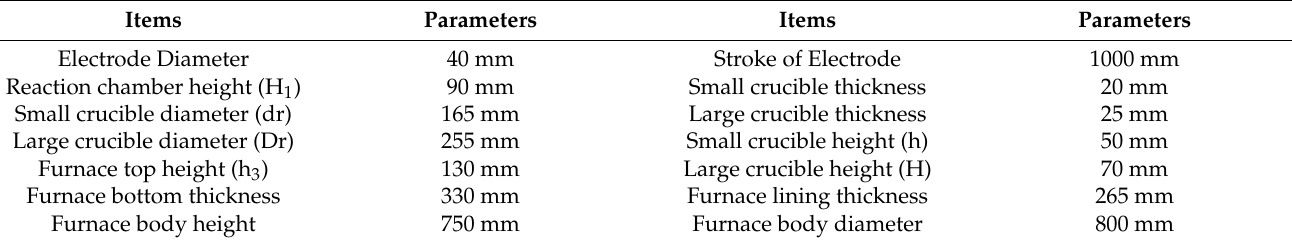
Table 5. Furnace structure parameters and corresponding dimensions.